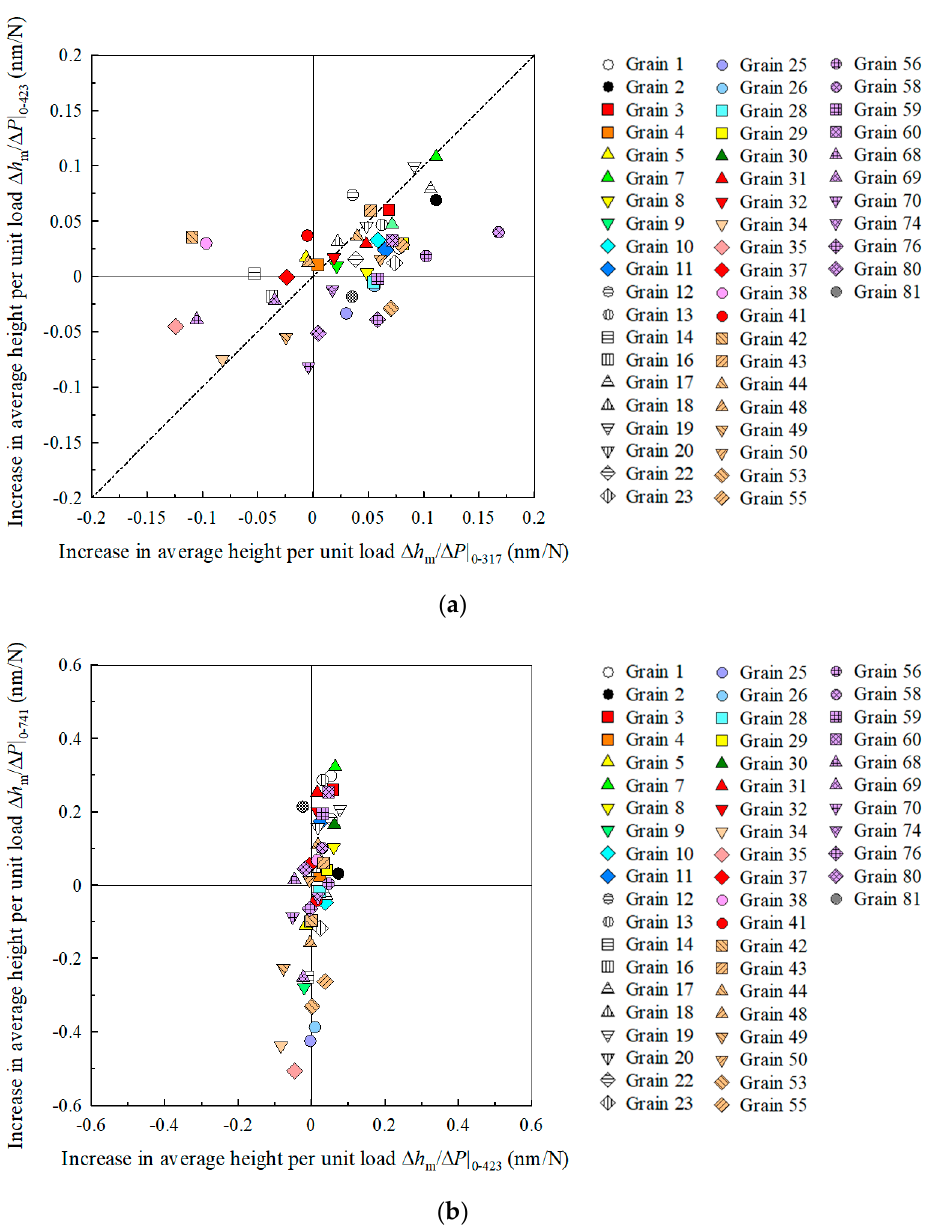
Figure 6. Relationship between average height change per unit load under elastic and plastic loading conditions. ( a ) Between the first (abscissa) and third (ordinate) load steps; and ( b ) between the third (abscissa) and seventh (ordinate) load steps [24].